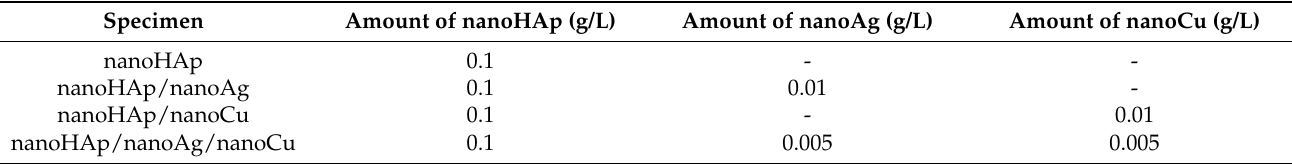
Table 2. Test variables, investigated components, and their